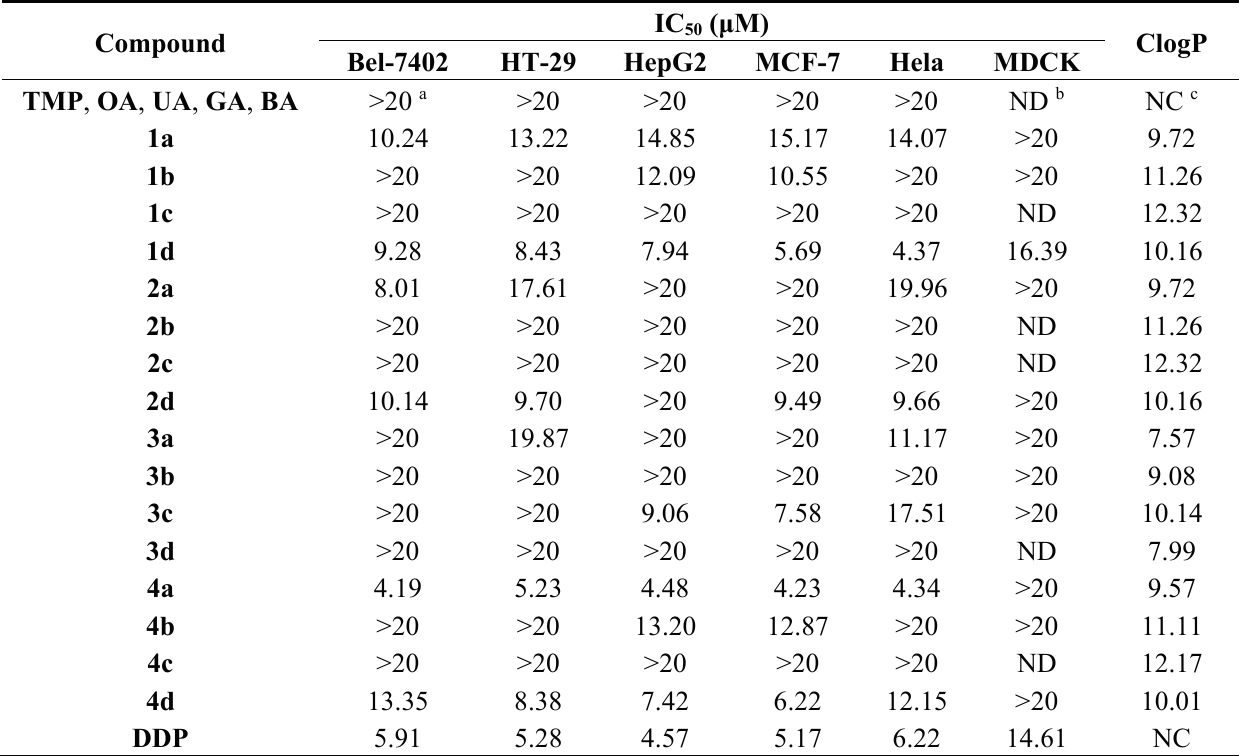
Table 1. Anti-proliferative effects and ClogP values of the target compounds and starting materials. Compound TMP , OA , UA , GA ,